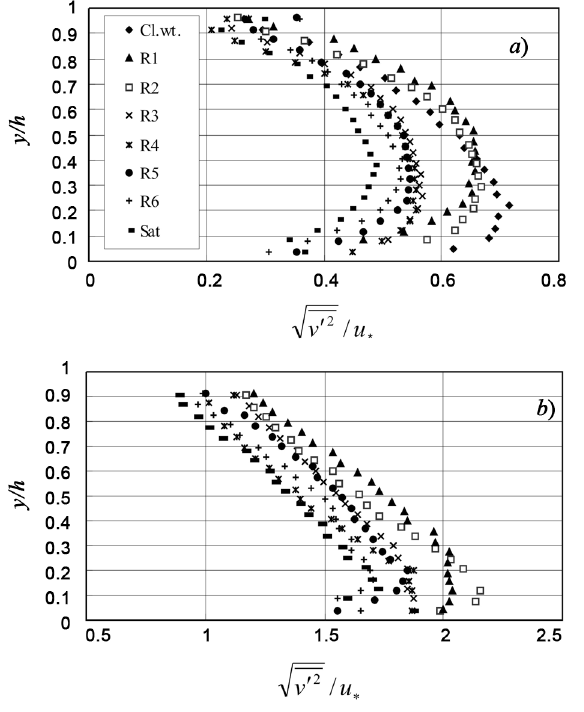
Fig. 5. Vertical profiles of turbulence intensity: a – the vertical velocity fluctuations, b – horizontal velocity